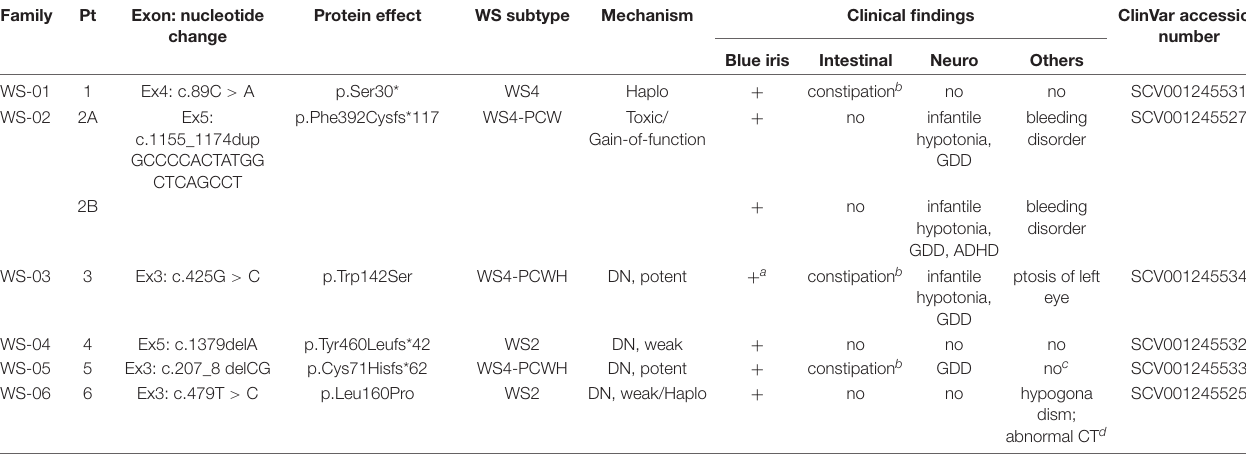
TABLE 1 | Clinical manifestations and genotypes including proposed pathologic mechanisms associated with SOX10 mutations. Family